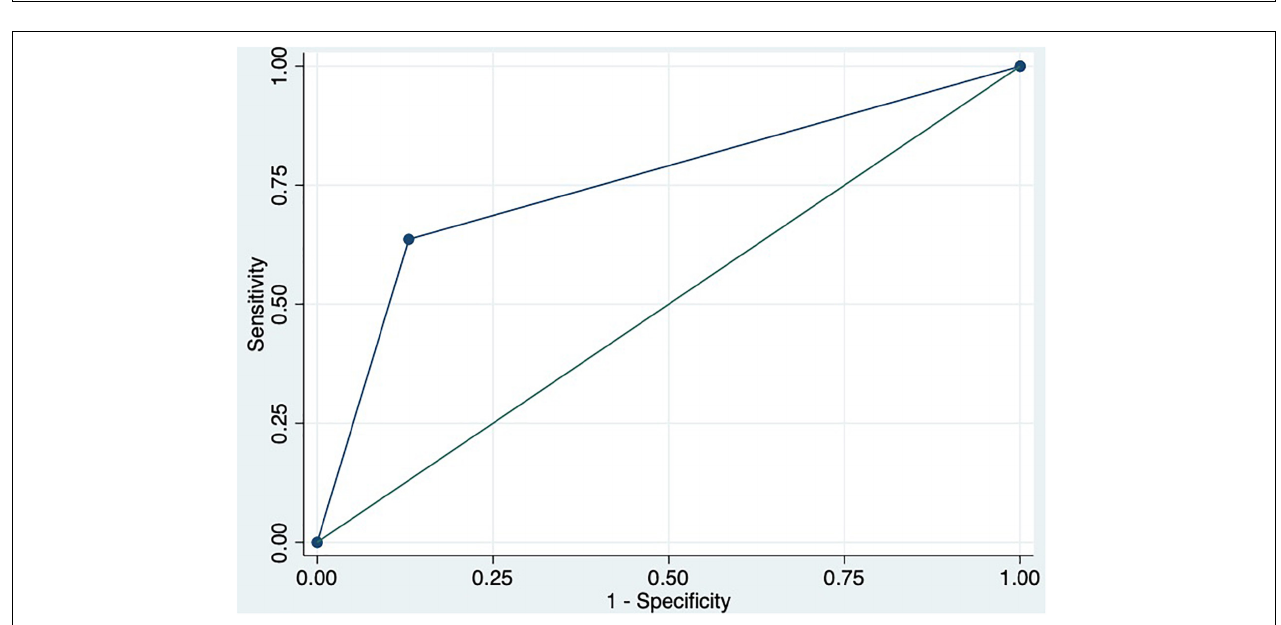
FIGURE 2 | ROC curves of spleen TE and damping index to predict acute response to beta-blockers.